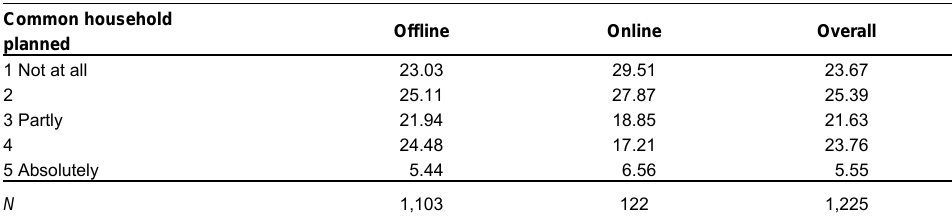
Table 11 : Future plan for common household (column-wise